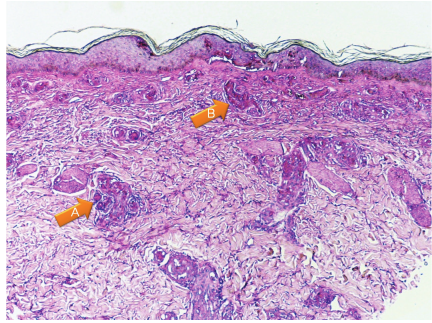
Figure 2: A. intravascular thrombosis B. Perivascular lymphocytic infiltrates.